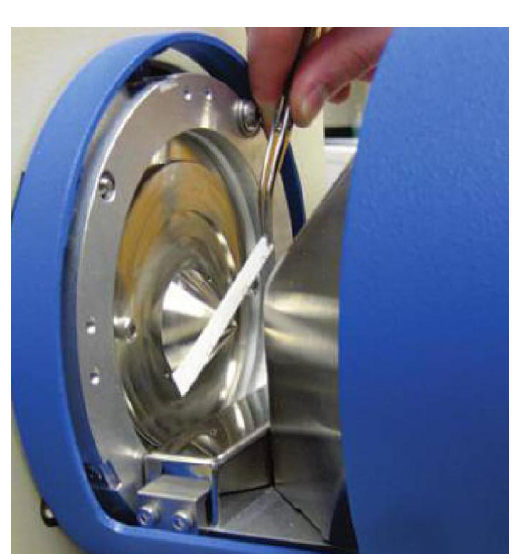
Figure 1. Introduction of a TLC plate to the DART-MS ionization region using the first generation of DART ion source models with a horizontally-aligned supply of the gas flow (reproduced from [10] with permission © 2008 American Chemical